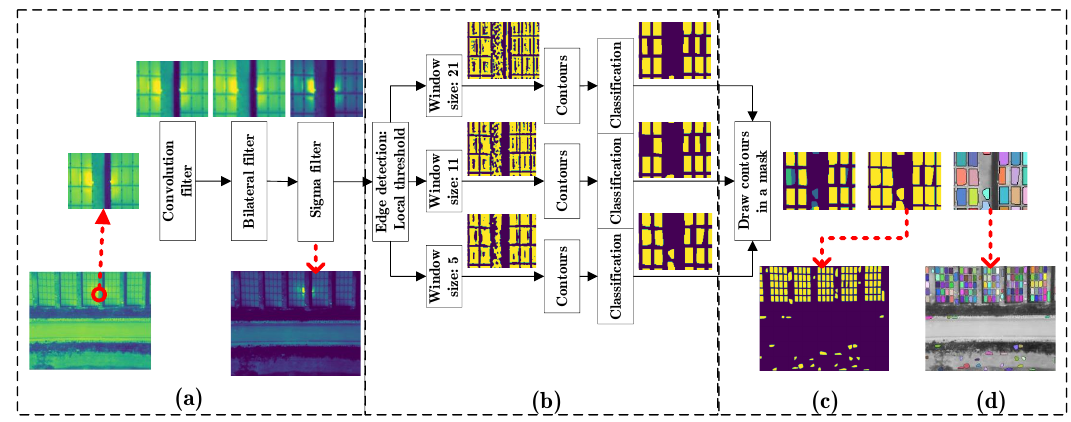
Figure 4. The image segmentation. ( a ) Image reprocessing. ( b ) Edge detection. ( c ) Mask with segments. ( d ) Panel detection of the first